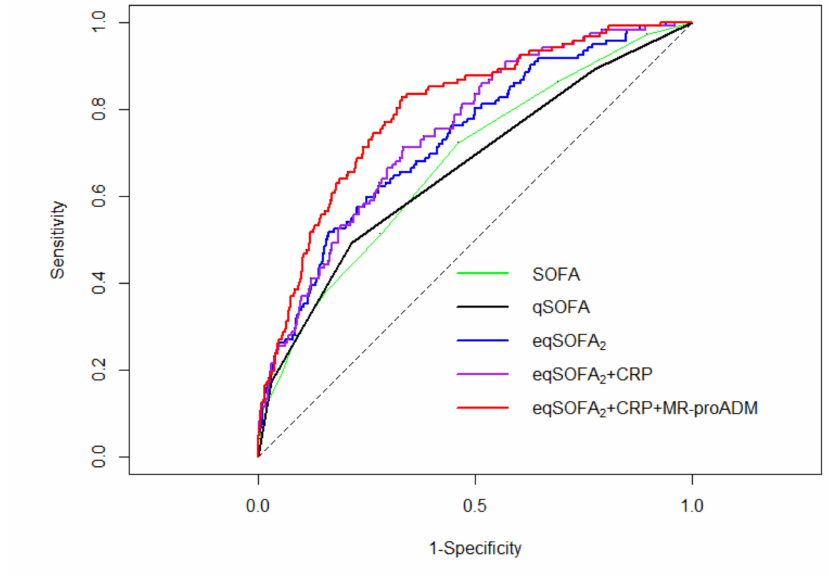
Figure 2. Group 2: Receiver operating characteristic curves of the sequential organ failure assessment (SOFA), quick sepsis-related organ failure assessment (qSOFA), “extended” qSOFA 2 derived in Group 2 (eqSOFA 2 ), eqSOFA 2 integrated with serum concentrations of C-reactive